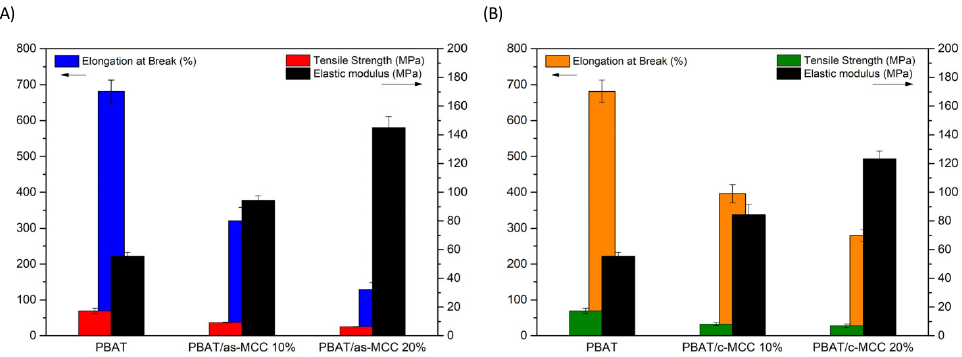
Figure 8. Histogram of elastic modulus, tensile strength, and deformation at break of ( A ) PBAT/as-MCC and ( B ) PBAT/c- MCC biocomposites.